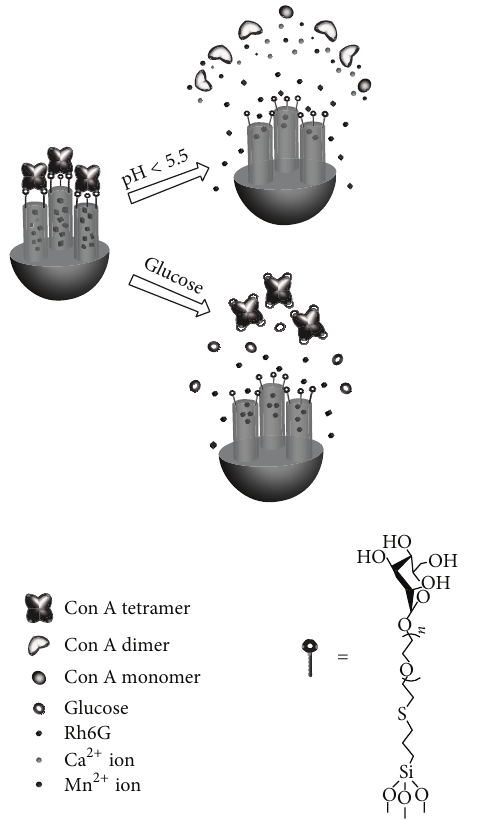
Figure 2: Illustration of the controlled release of cargo from Con A-gated mannose-functionalized mesoporous SiO 2 nanocontainers in response to changes in pH value and glucose concentration (reproduced from [51], with permission from Wiley-VCH Verlag GmbH & Co. KGaA).